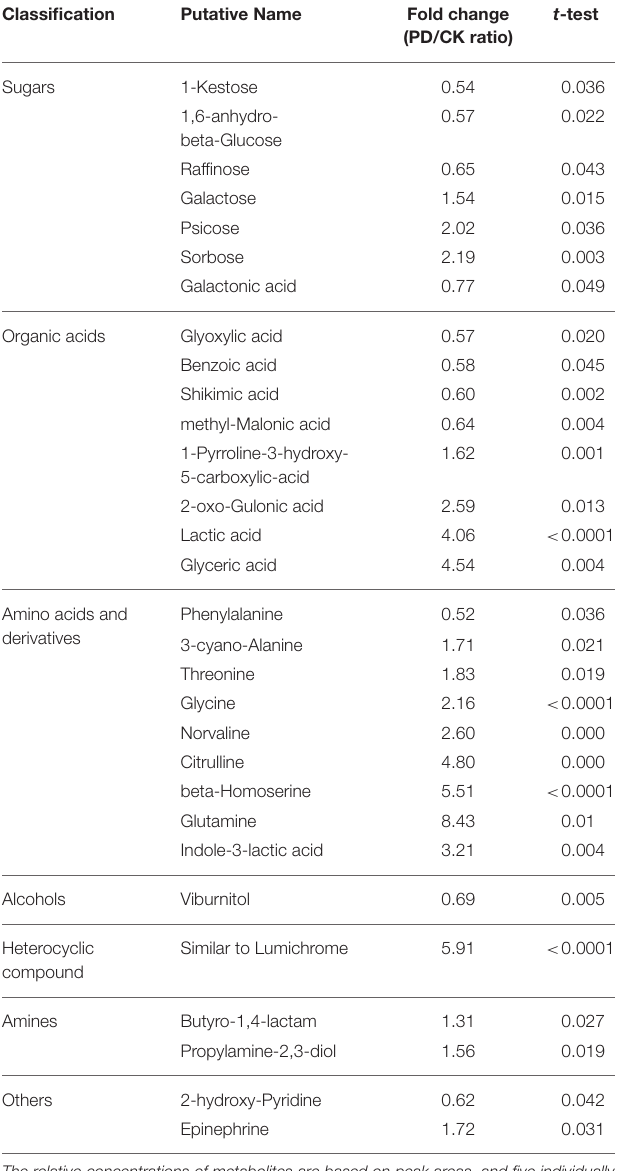
TABLE 2 | Amino acids in CK and RD peels. Values are mean ± SD of three biological replicates.